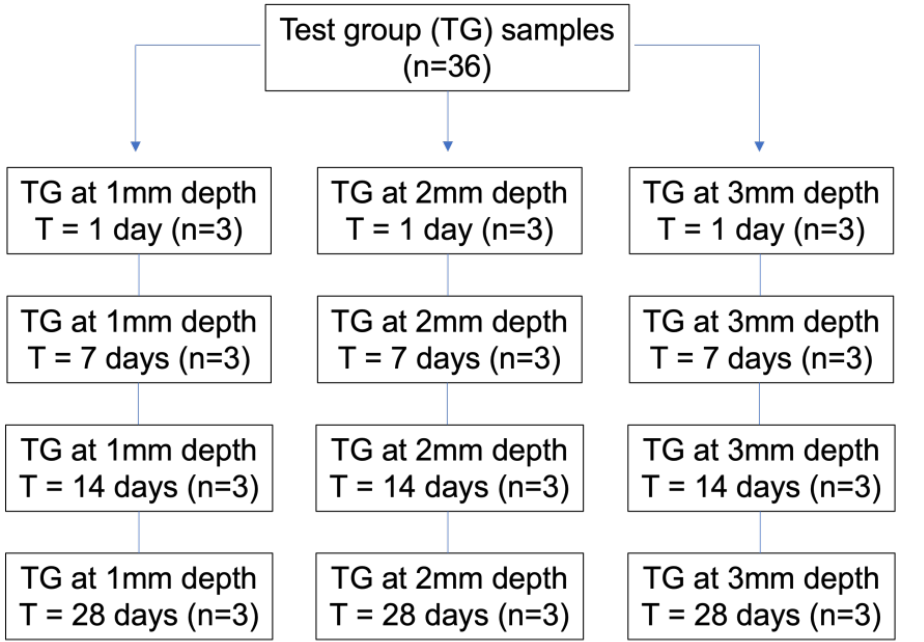
Figure 1. Flowchart representing the different test groups. Three test groups (TG) were assessed (KM, EF, and RL (n = 36 each)). Three different dentin depths were tested (1, 2, and 3 mm). Four different time points were tested (1, 7, 14, and 28 days).